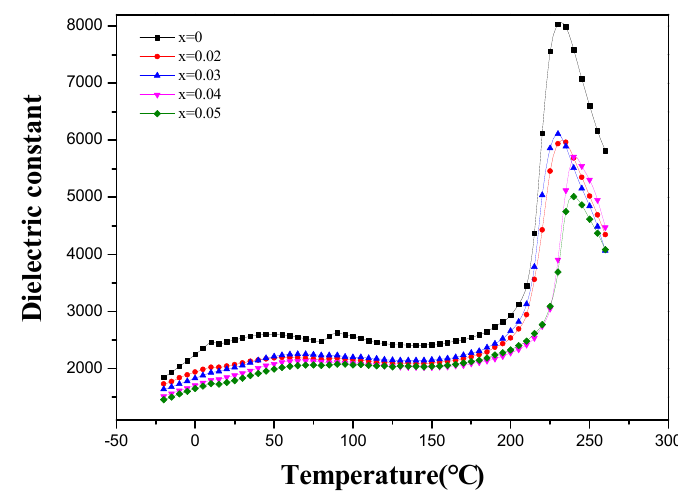
Figure 9. Temperature dependence of dielectric constant with x.